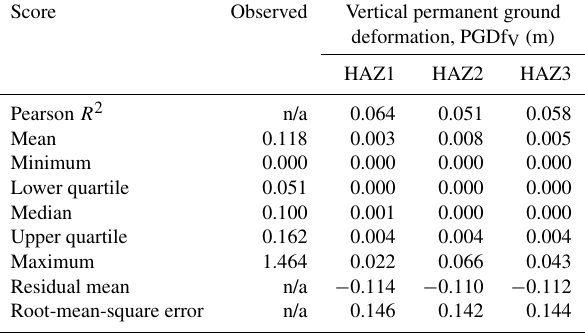
Table 8. Summary statistics of vertical ground deformation (PGDf V ) estimates for Darfield and Christchurch earthquakes from HAZUS models. Refer to Table 4 for descriptions corresponding to model